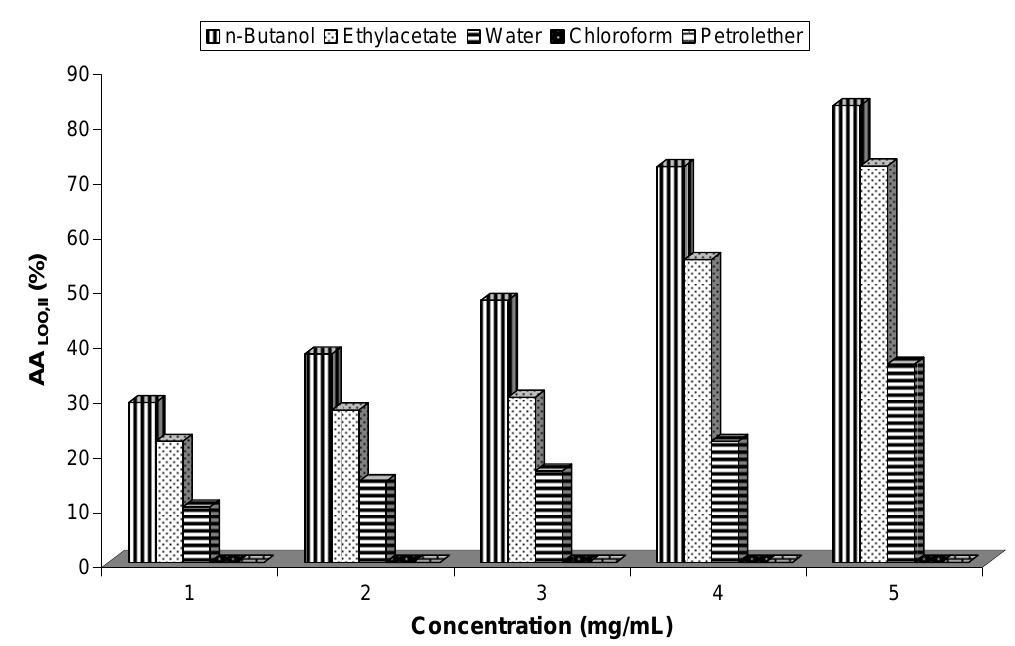
Figure 5. Antioxidant activity of different concentrations of n -butanol, ethyl acetate, water, chloroform and petroleum ether extracts of Satureja montana L. subsp . kitaibelii on PBN-OOL spin adduct during AAPH-induced peroxidation of liposomes (Data are represented as inhibition percentage of PBN-OOL spin adduct peak height measured by